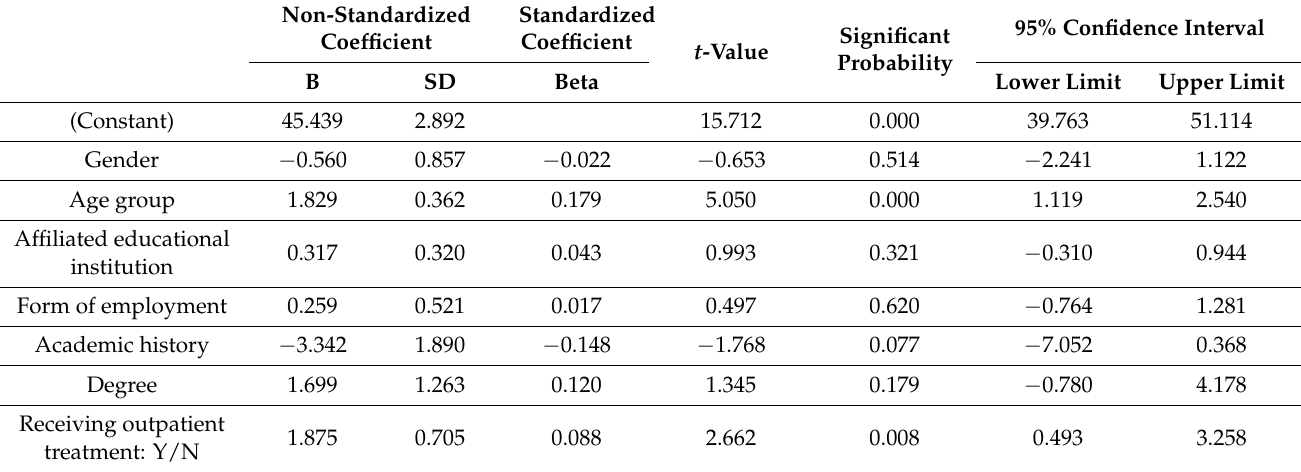
Table 2. Factors influencing sense of coherence: linear multivariate regression analysis.